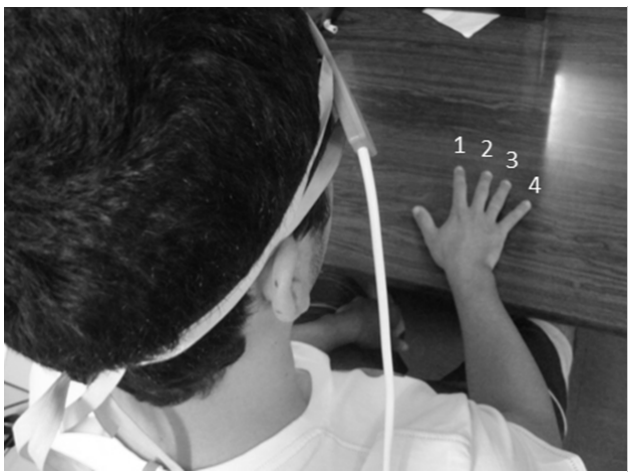
Figure 4. Participant performing finger tap during a proposed motor task.